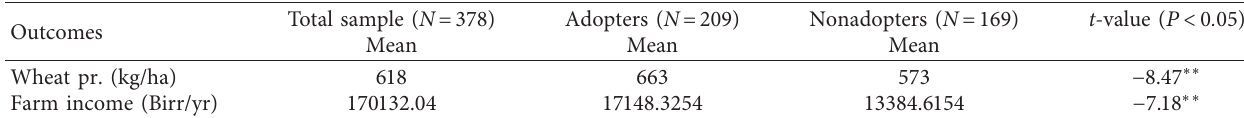
Table 5: Descriptive results of potential outcome